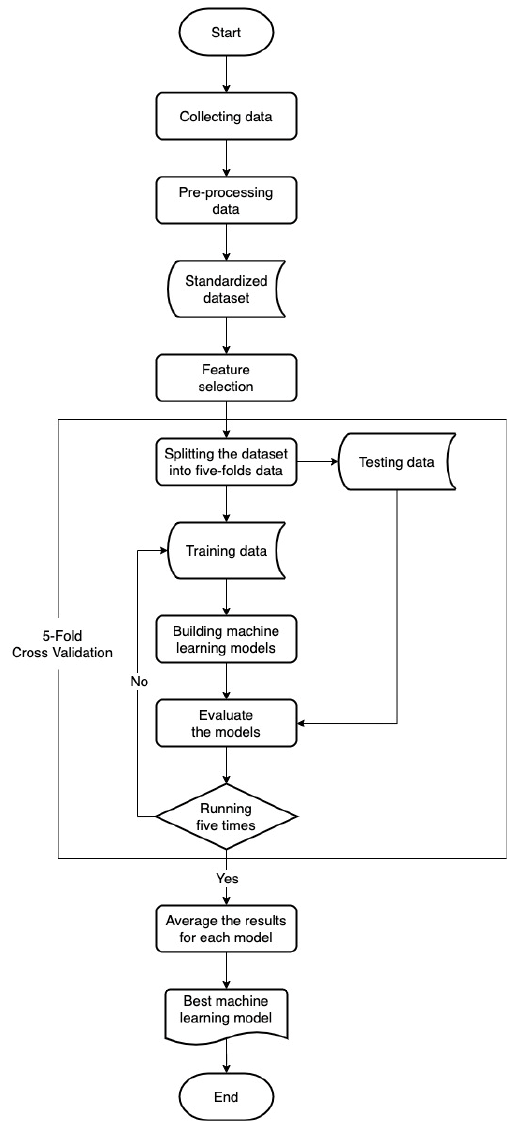
Figure 2. Research